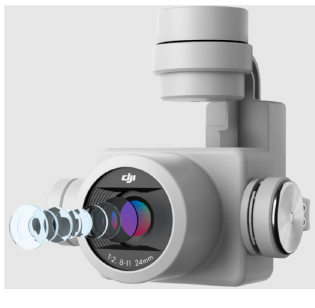
Figure 4. FC6310 camera. Table 1. Camera parameters.